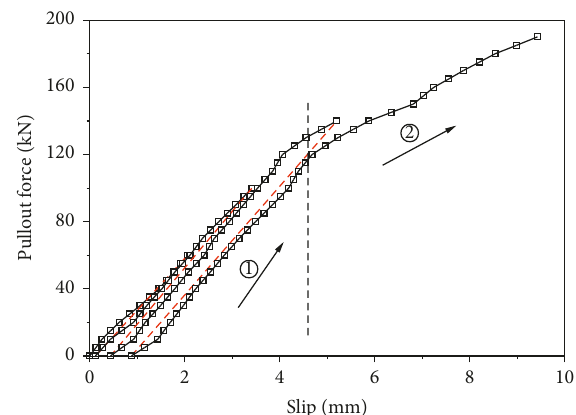
Figure 15: Cyclic load-slip curves obtained under strong constraint